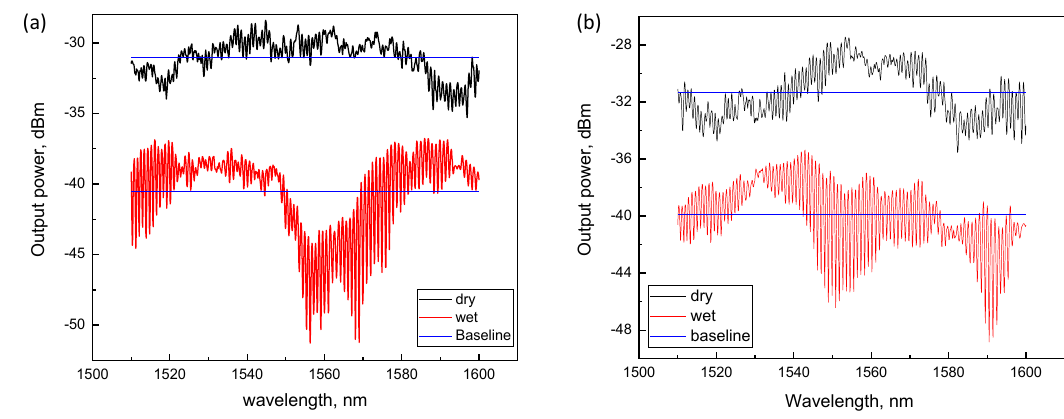
Figure 5. Transmission spectra of OMF in different volatile mixtures: ( a ) ETM ( b ) DII . Blue lines represent the baselines corresponding to dry and wet conditions for each